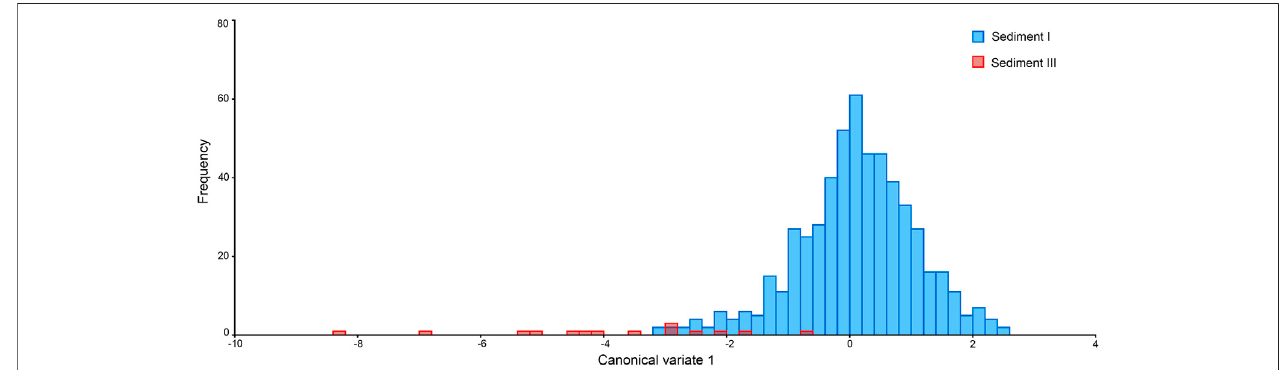
FIGURE 5 | Canonical variable frequency bar chart of Sed I and Sed III samples from the Dingsishan Site.